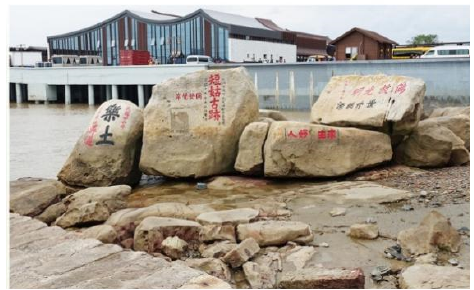
Figure 7. Stone inscriptions at Duangu Pier now.